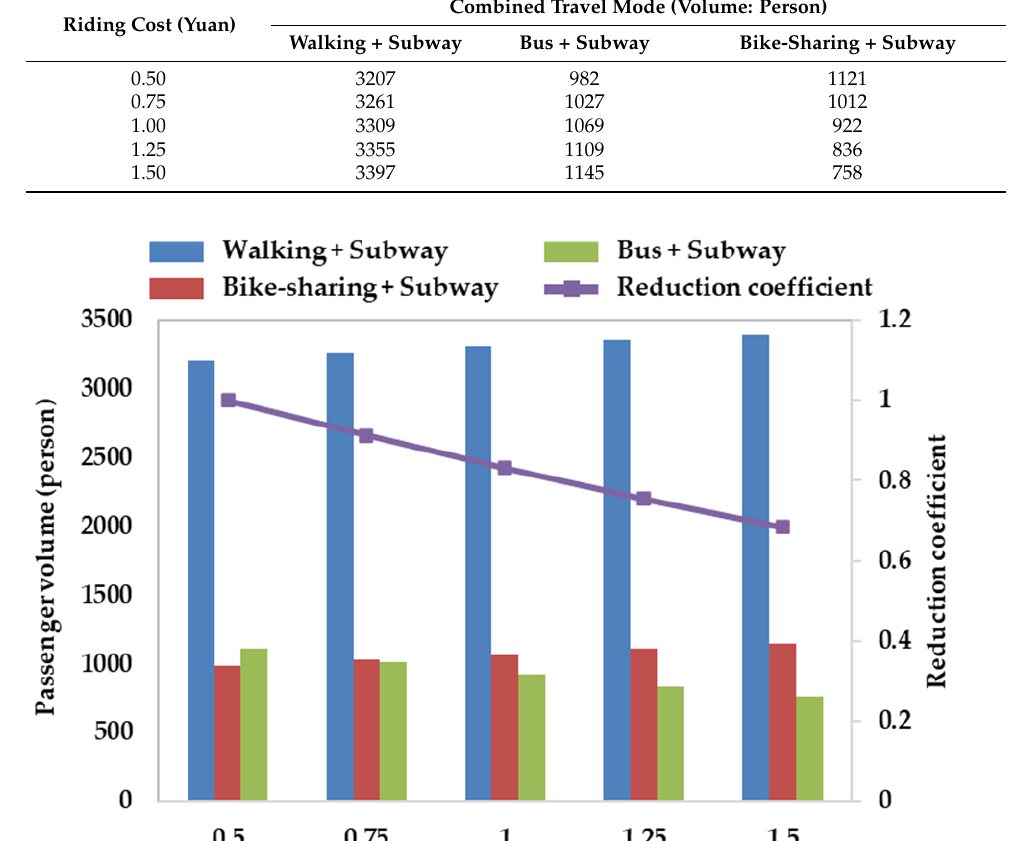
Table 6. Volume variation of three modes.